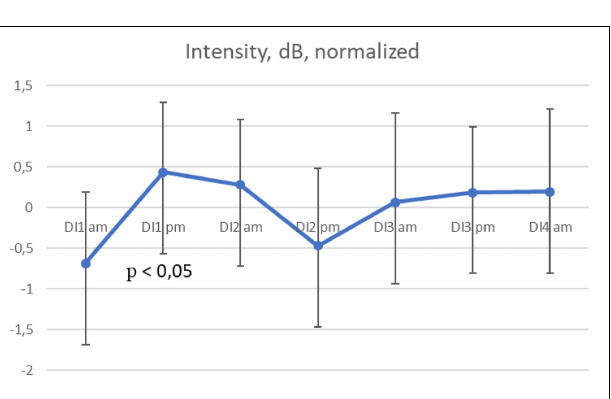
FIGURE 2 | Average intensity per morning/evening during the 3-days “dry” immersion experiment. Mean ±